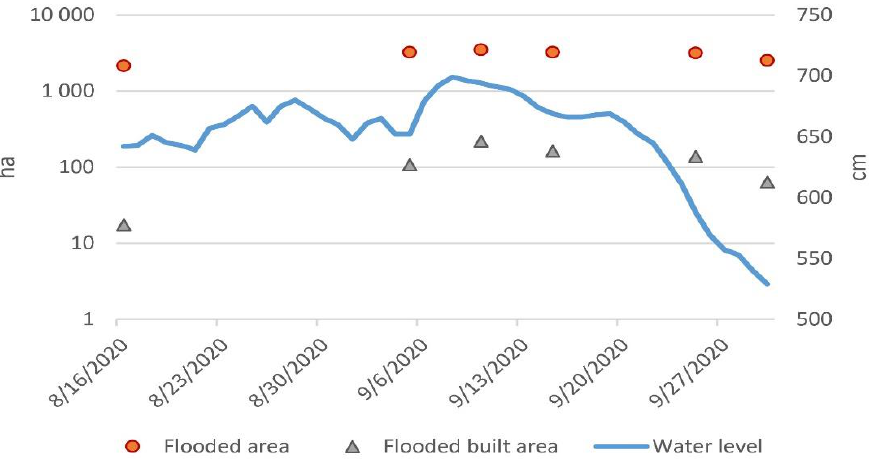
Figure 5. Evolution of flooded areas in Niamey during the 2020 flood (21/8, 26/8, 31/8 and 20/9 images were not usable due to cloud coverage).